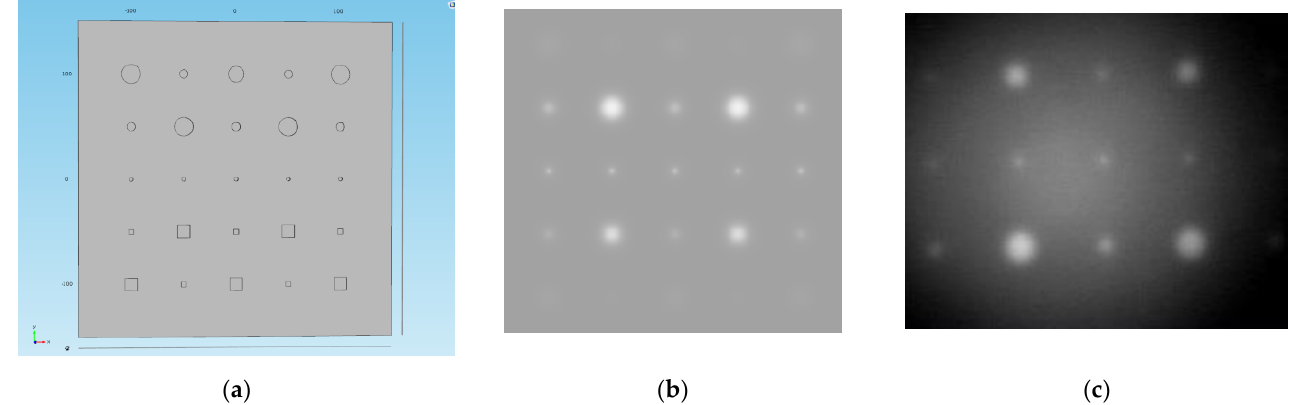
Figure 4. ( a ) Finite Element Modeling (FEM) 3D model; ( b ) Simulated thermogram at t = 106.5 s; ( c ) Real experimental data t = 106.5 s.